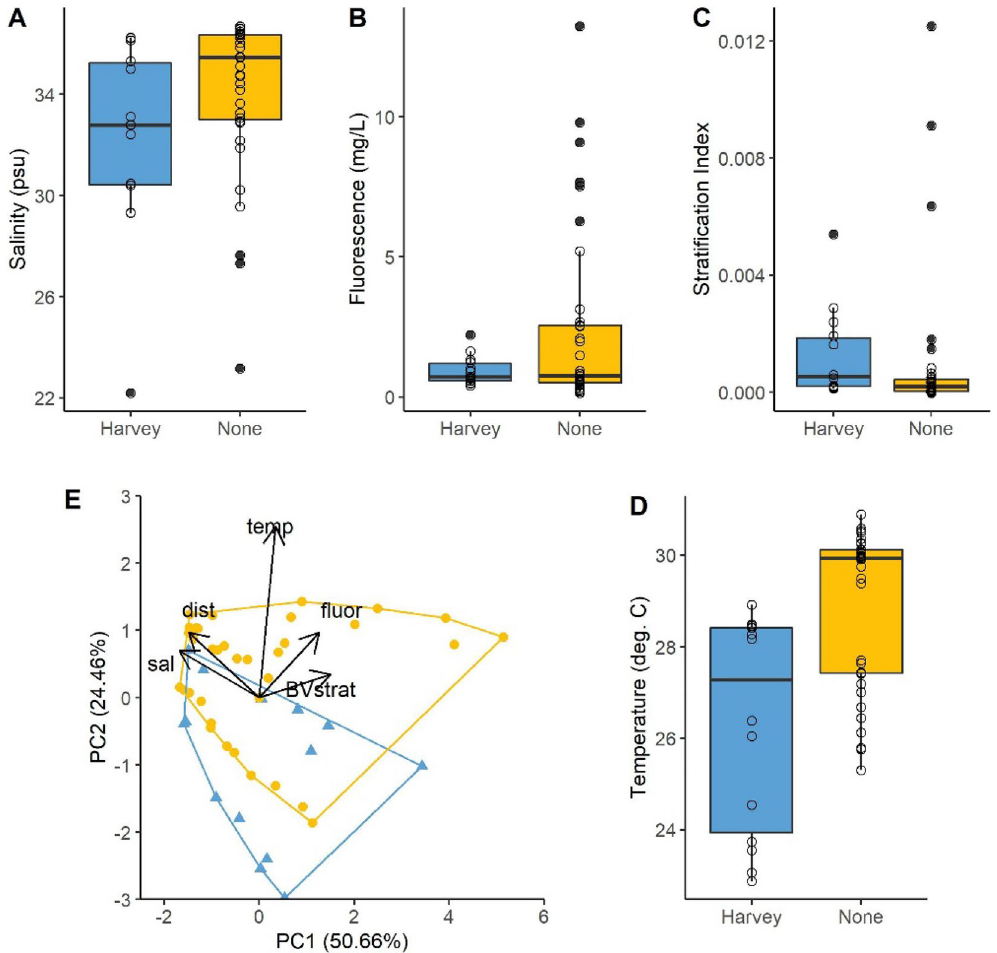
Figure 3. Distribution of ( A ) salinity, ( B ) fluorescence, ( C ) temperature, and ( D ) stratification index between Hurricane Harvey and non-storm years. ( E ) PCA of environmental observations (n = 62). Sal salinity (psu), fluor fluorescence (µg/mL), temp temperature (°C), BVstrat stratification index, dist distance from shore (km).